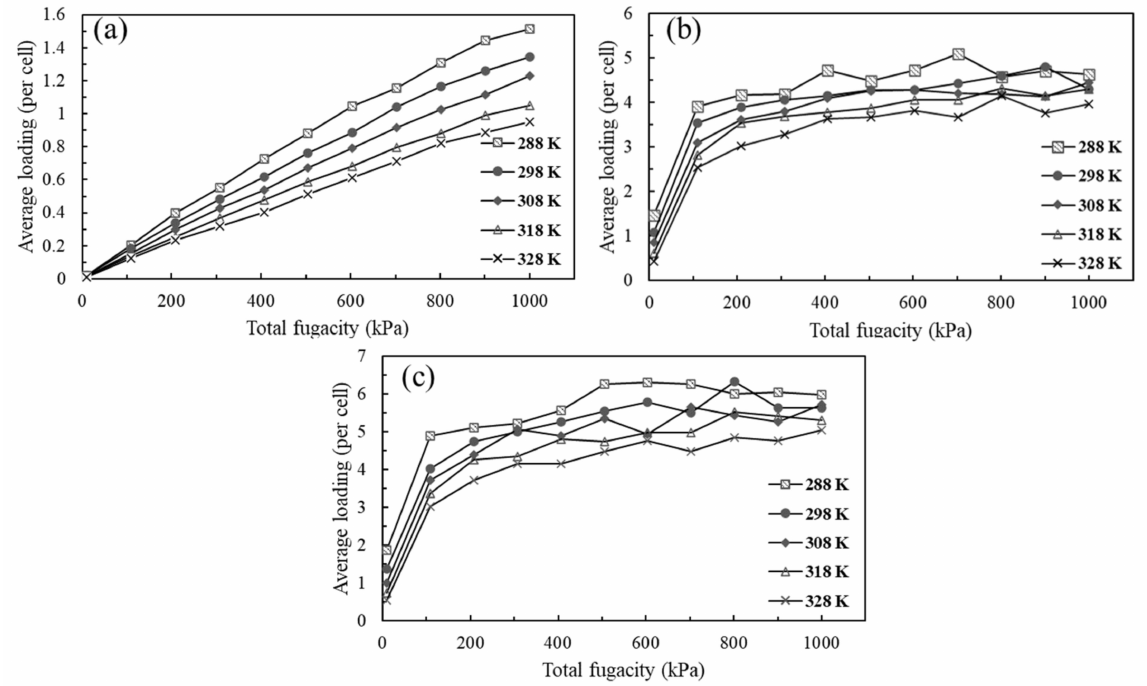
Figure 8. Adsorption isotherm of ( a ) N 2 , ( b ) C 3 H 8 and ( c ) C 3 H 6 in PDMS membranes at different temperatures.